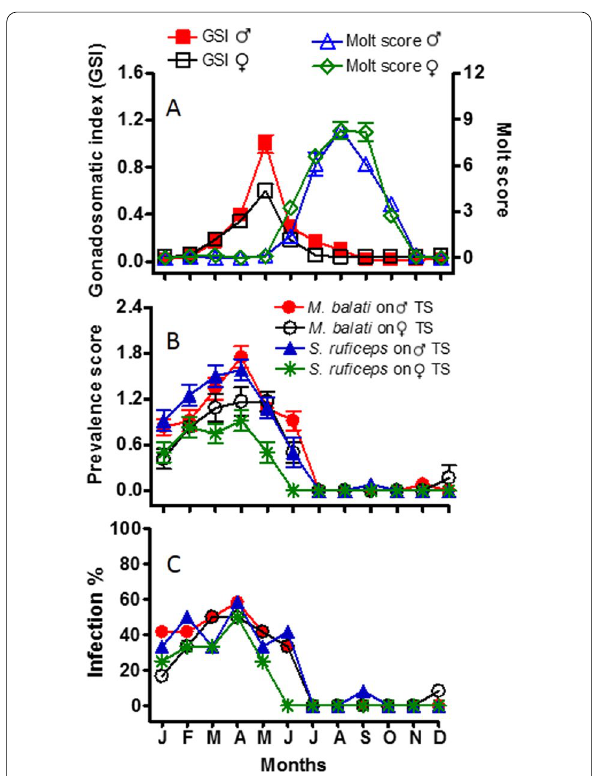
Fig. 2 Annual changes in gonadosomatic index and molt score ( A ), prevalence score ( B ) and infection percentage of Myrsidea balati and Sturnidoecus ruficeps ( C ) in both sexes of the tree sparrow